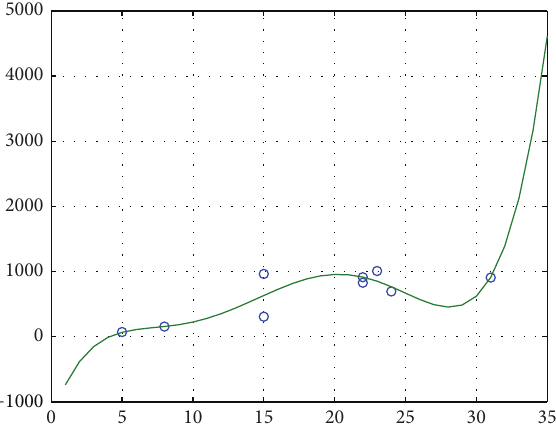
Figure 5: Number of leaf nodes and number of